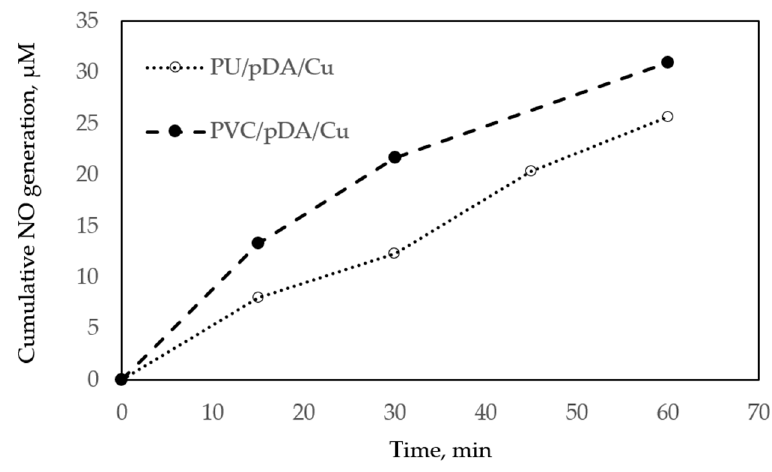
Figure 7. NO generation after incubation of Cu-modified polymers with 100 μ M GSNO/GSH in the PBS.